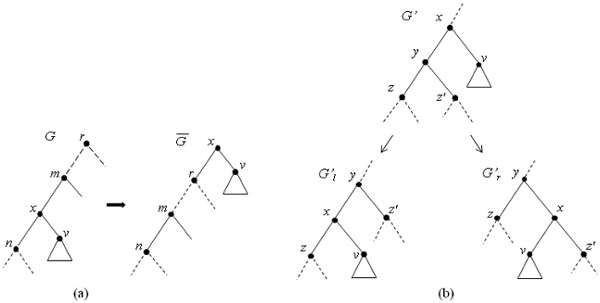
The NNI adjacency graph. (a) The tree G¯ is obtained from G by pruning and regrafting subtree Gv to the root of G. The vertex x ∈ V(G) is suppressed, and the new vertex above root in G¯ is named x. (b) Two NNI operations NNIG'(z') and NNIG'(z) produce left-child G'l and right-child G'r of G' in  X .